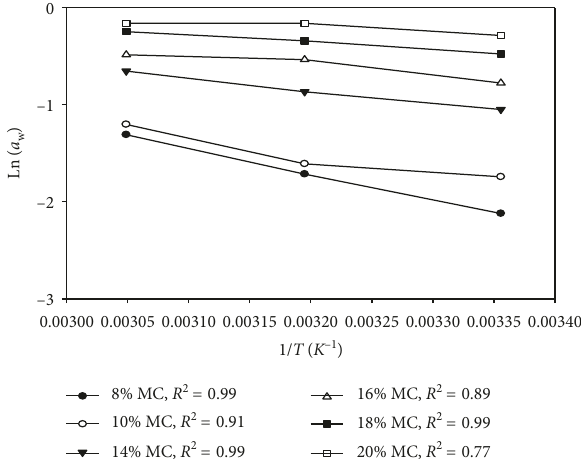
Figure 5: Isosteric heat of sorption Ln a for millet flour epoxy resin at constant moisture content.